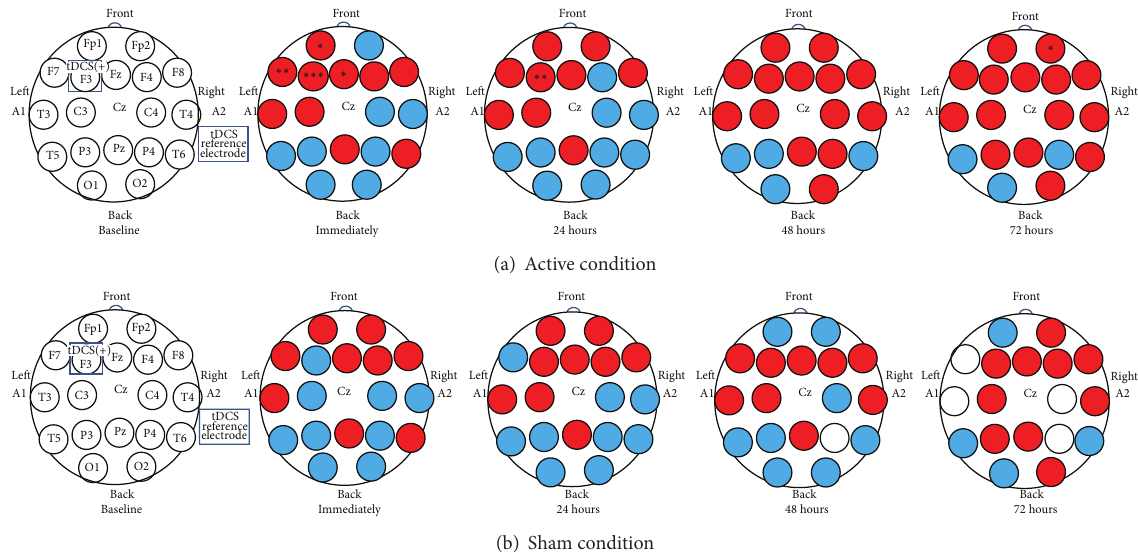
Figure 1: Changes in peak alpha frequency (PAF) at 18 electrode sites (referenced to Cz) after active and sham tDCS stimulation over dorsolateral prefrontal cortex (F3), relative to baseline. In the active condition, significant differences in PAF were found at 5 electrode sites: Fp1, Fp2, F7, F3, and Fc. Immediately after stimulation, PAF significantly increased at Fp1, F7, and Fc; significant increases in PAF at Fp2 were found at 72 hours after stimulation. At the stimulation site (F3), increases in PAF were found immediately and at 24 hours after stimulation. In the sham condition, PAF did not have any significant changes at any time point at any of the 18 electrode sites. Red = increase; blue = decrease; white = no changes; ∗ significant different main effect of time; ∗ 𝑃 < 0.05 ; ∗∗ 𝑃 < 0.01 ; ∗∗∗ 𝑃 < 0.001